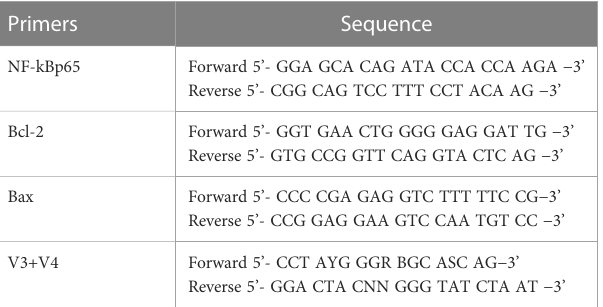
TABLE 1 Primer sequences used for region Real-time quantitative -PCR and 16SV3+V4 ampli fi cation. Primers